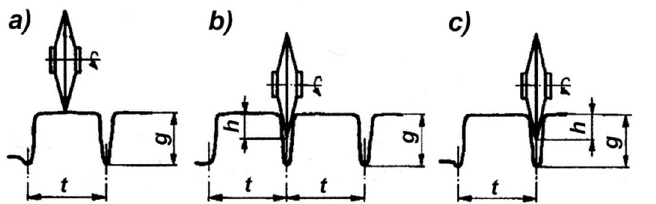
Figure 3. Diagram of the arrangement of slots cut with high-pressure jets in relation to the disk tool, ( a ) on the sides of the tool, ( b ) on the sides and along the axis of the tool and ( c ) on one side and along the axis of the tool [11,12].